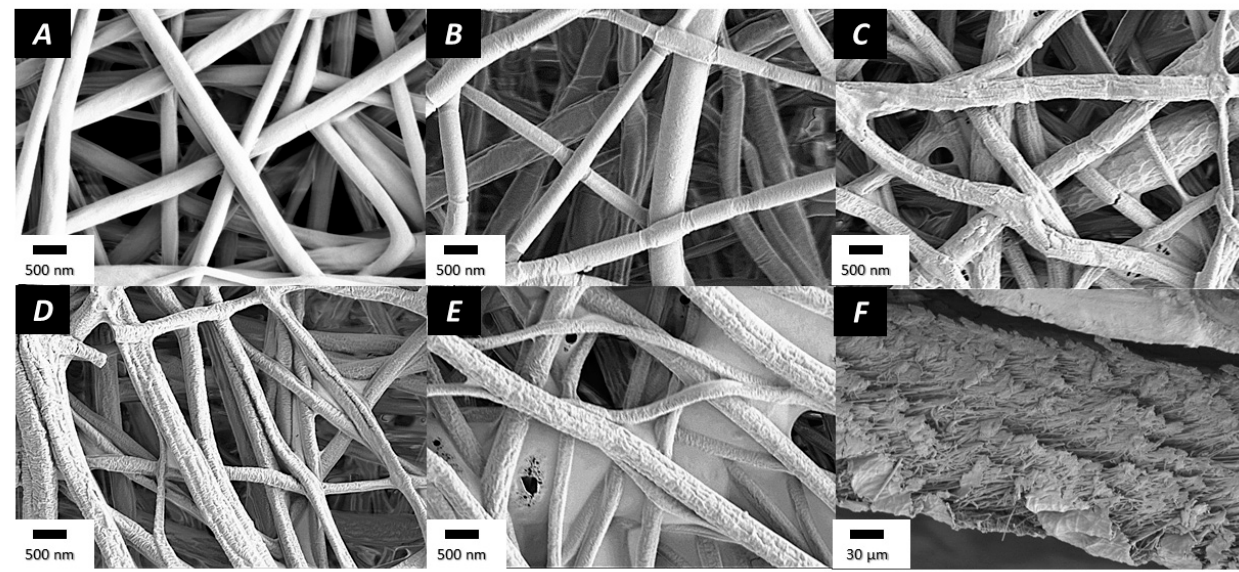
Figure 2. SEM pictures of ( A ) PLGA nanofibers, ( B ) plasma-coated nanofibers, ( C ) (CHI/ALG) 5 , ( D ) (CHI/ALG) 9 , ( E ) (CHI/ALG) 15 , and ( F ) cross-section of (CHI/ALG) 15 layers.